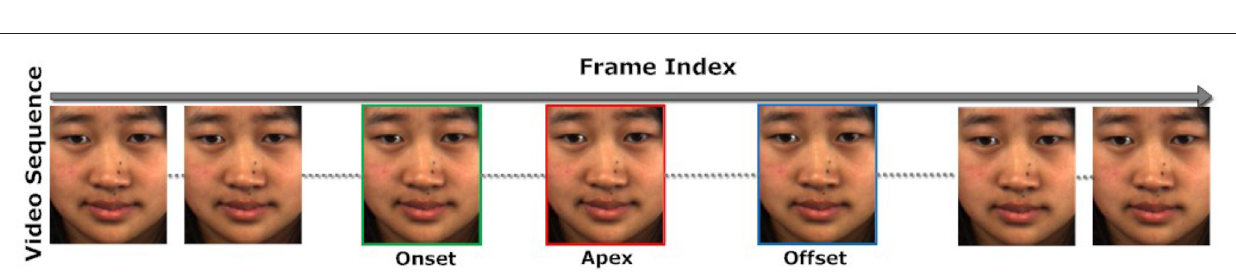
Frontiers in Psychology |